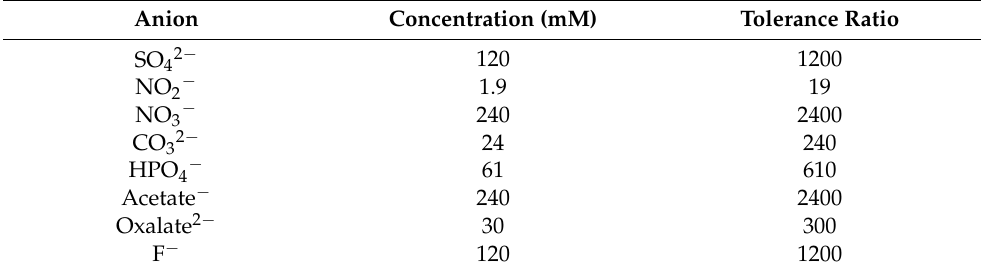
Table 3. The experimentally determined tolerance of Tl(III) sensor to other anions ( c sensor = 0.1 mM). Anion